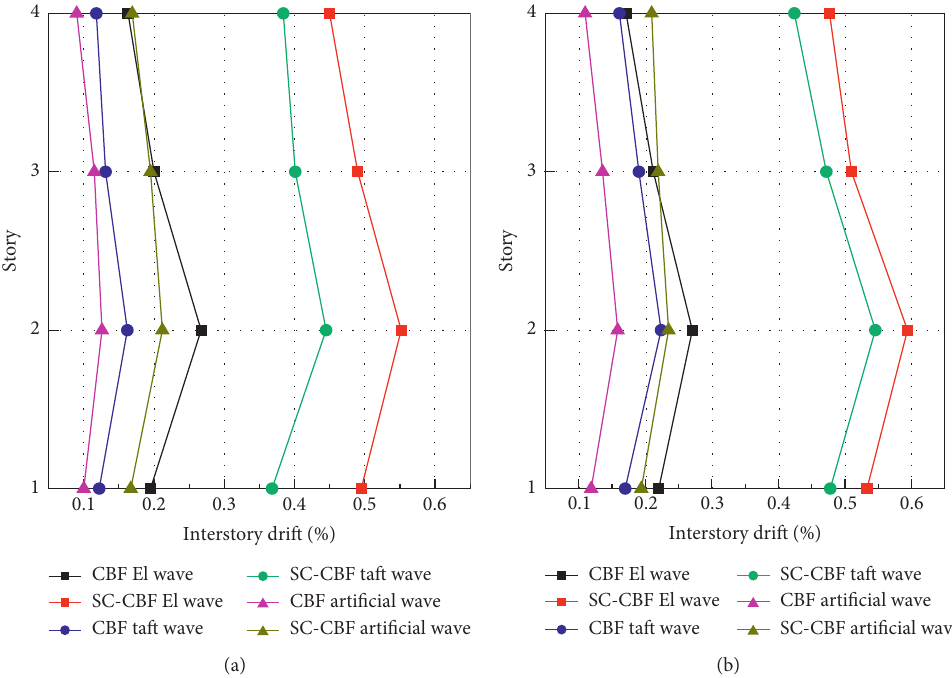
Figure 20: Peak interstory drift of 4-story structure under earthquake actions: (a) rare earthquake; (b) extremely rare